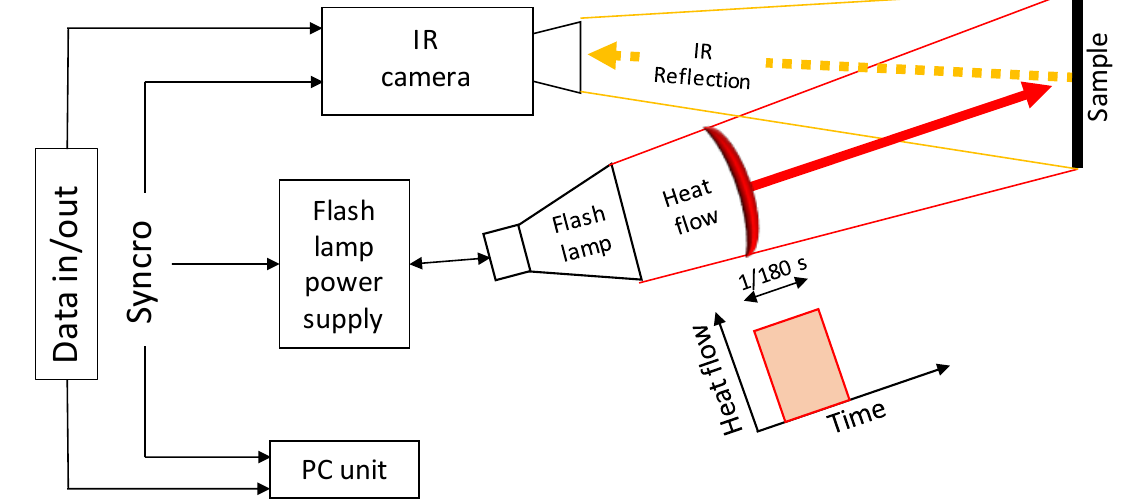
Figure 3. Schematic representation of the Pulsed Thermography experimental setup.